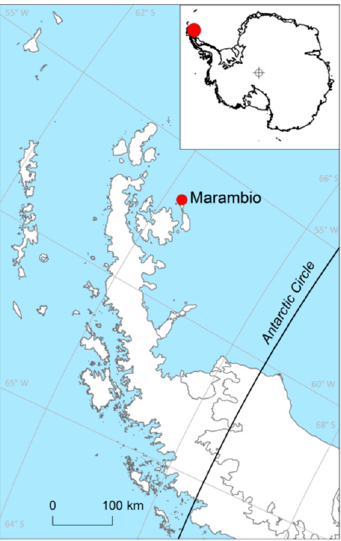
Figure 1. The localization of the Marambio Base on Seymour Island, Eastern Antarctic Peninsula.